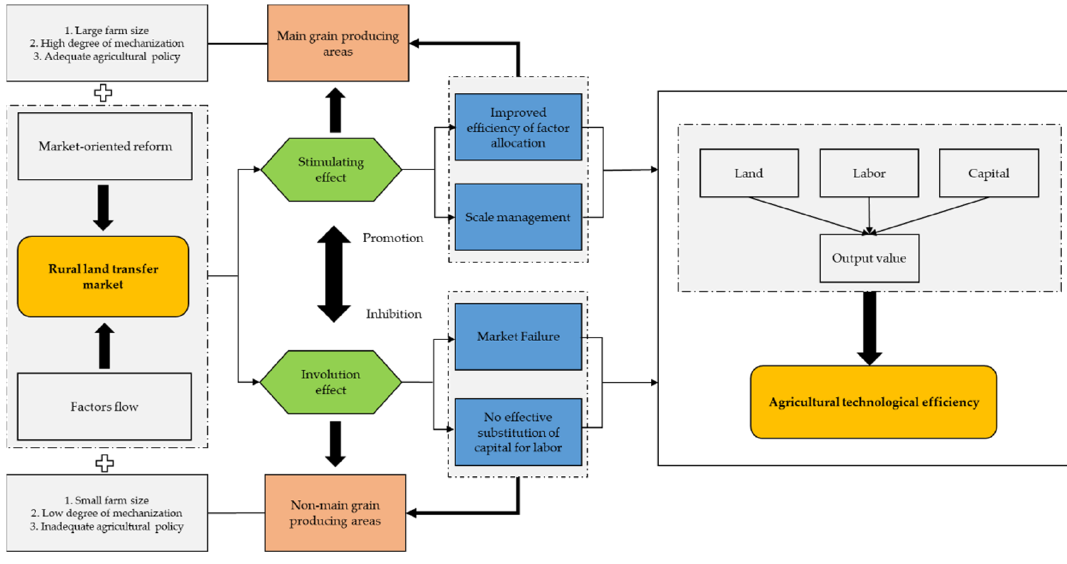
Figure 2. Theoretical framework.